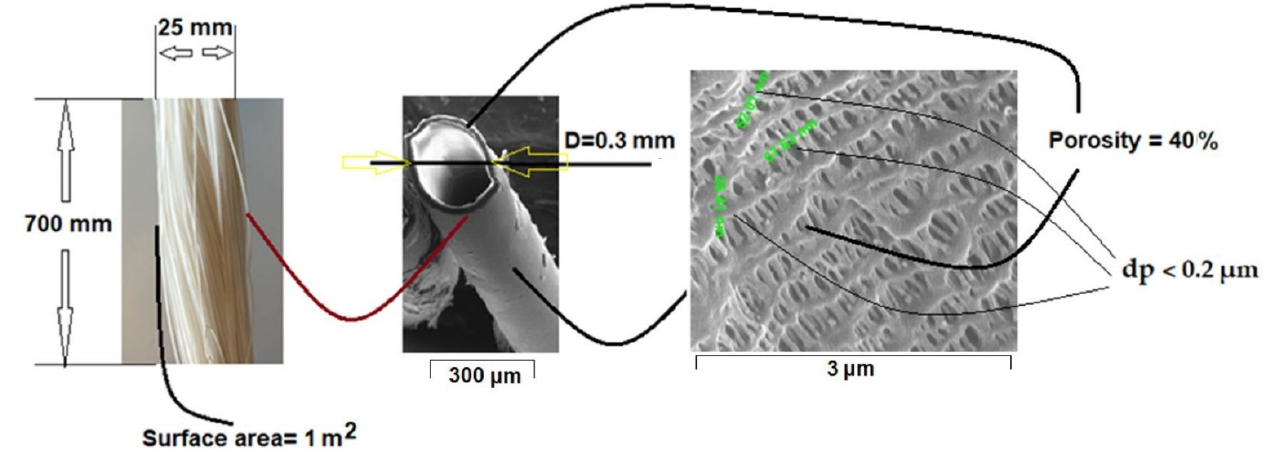
Figure 2. The typical characteristics of the polypropylene hollow fiber membrane (PPM).